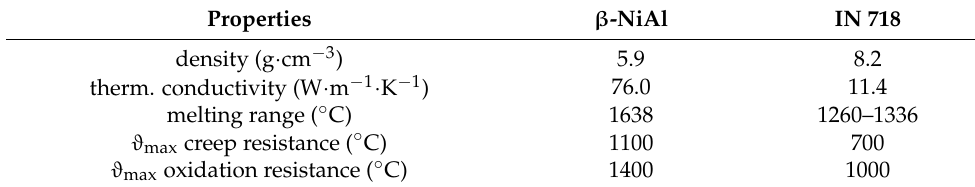
Table 1. Comparison of state-of-the art nickel-based superalloy IN 718 and β -NiAl [3,4].